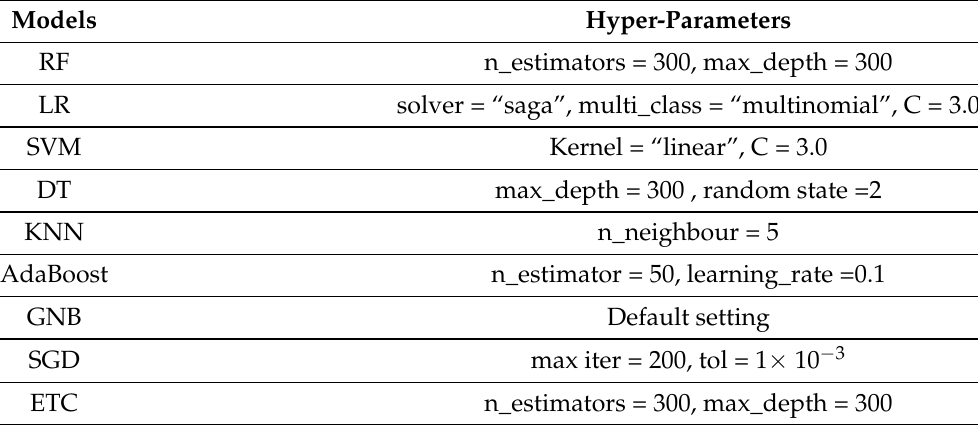
Table 9. The hyper-parameter settings of machine learning